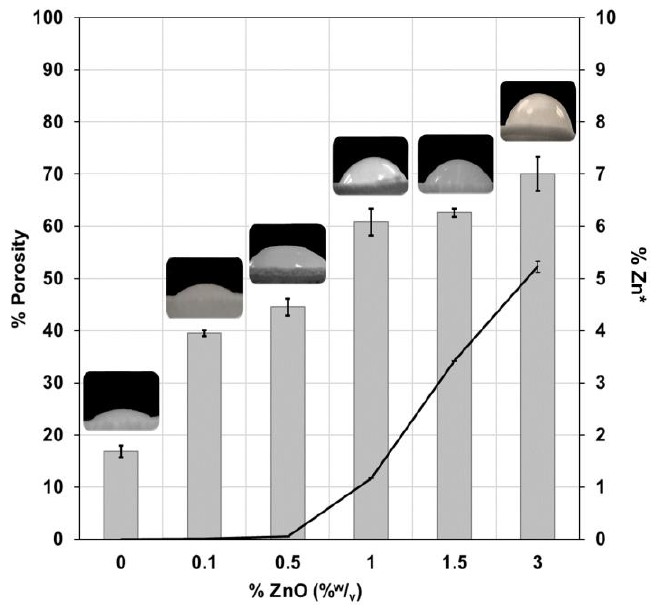
Figure 4. Characterization of the membrane. Percentage of porosity of CA/ZnO hybrid membrane with different ZnO concentrations (bars). Experimental conditions: 10 mL of deionized water; contact time 24 h; 2 cm 2 of CA/ZnO prepared with 3% of NP in polymeric solution. Amount of zinc present in the membrane determined by EDS (* percentage of weight of zinc, line). Contact angle.